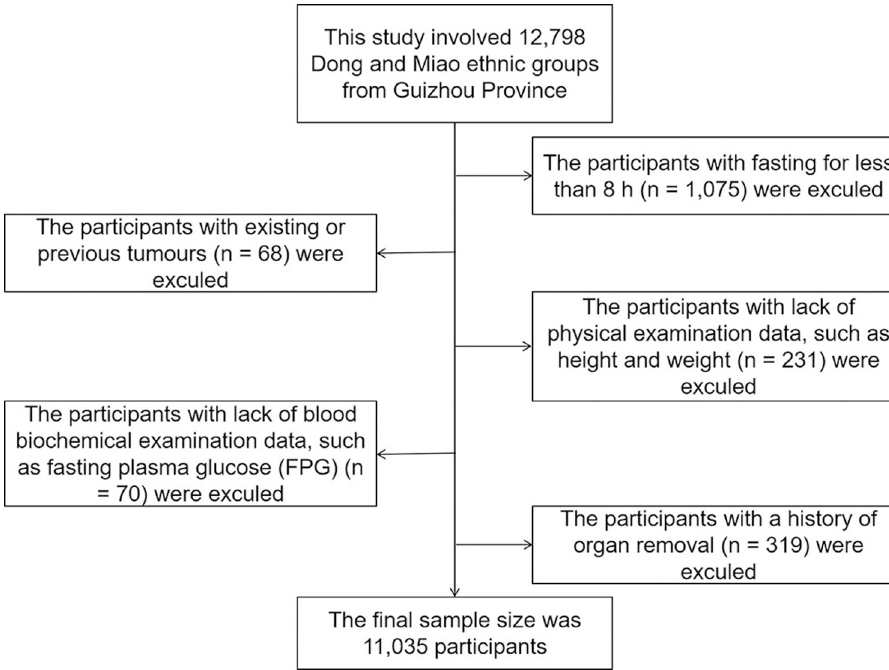
Fig 1. Flowchart showing the process of participants’